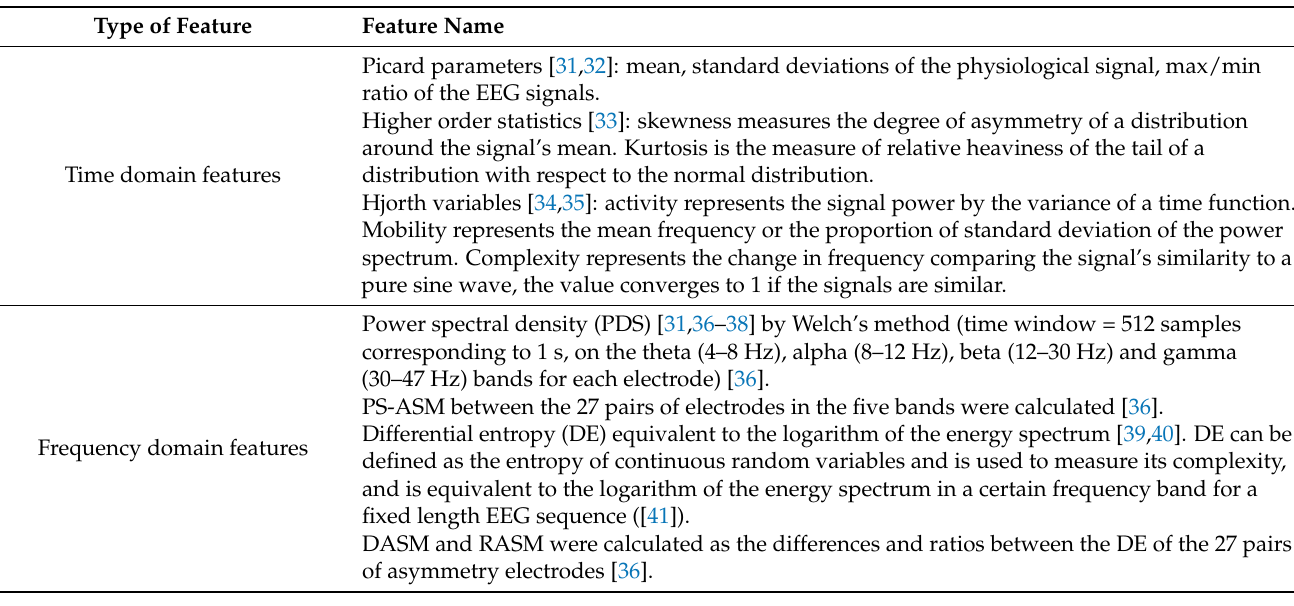
Table 2. Signal traits calculated for the physiological